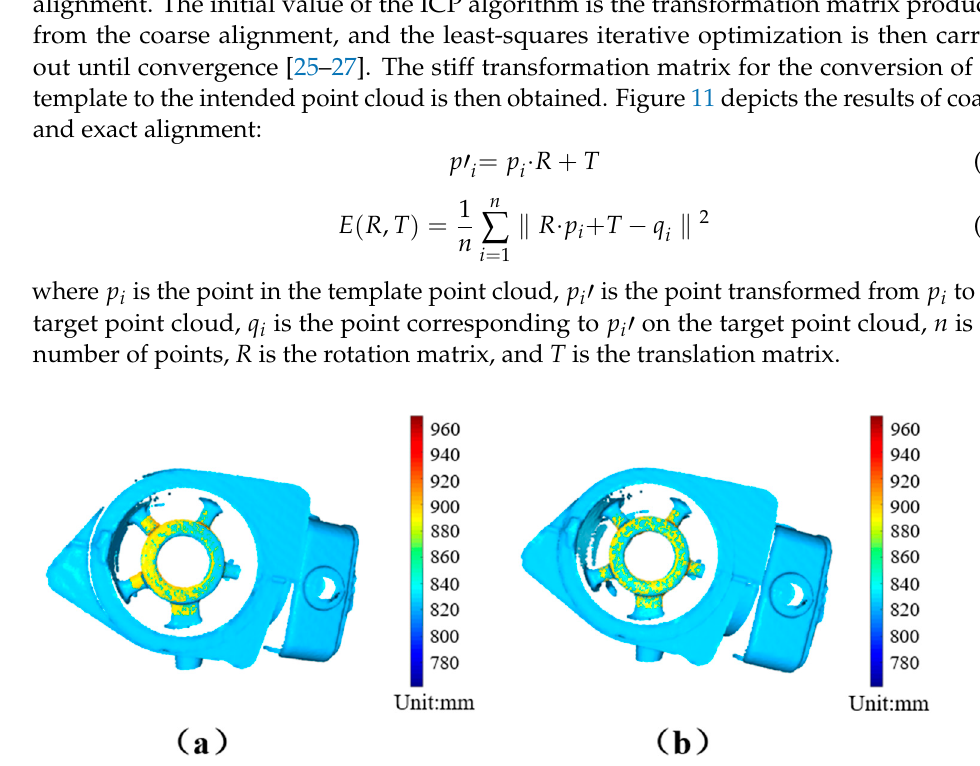
Figure 10. Partial template.